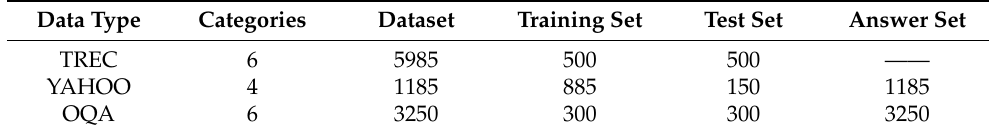
Table 3. Dataset